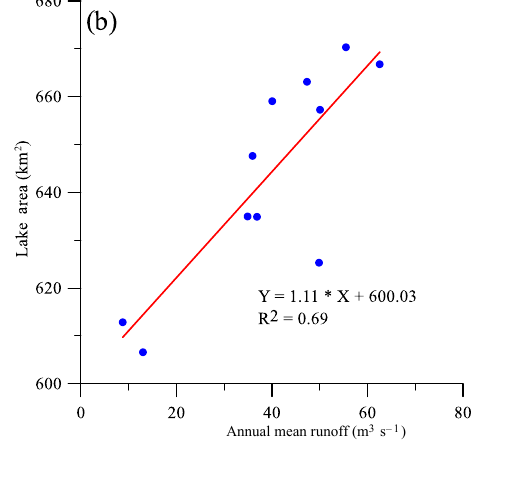
Figure 7. Relationship between lake area and respective outlet